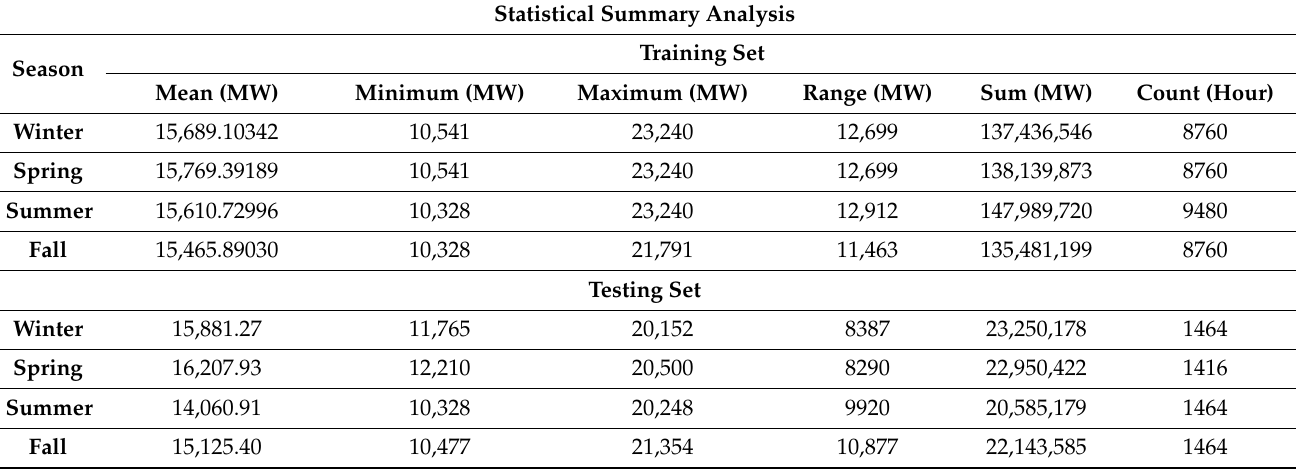
Table 2. Statistical summary analysis of training and testing datasets. Statistical Summary